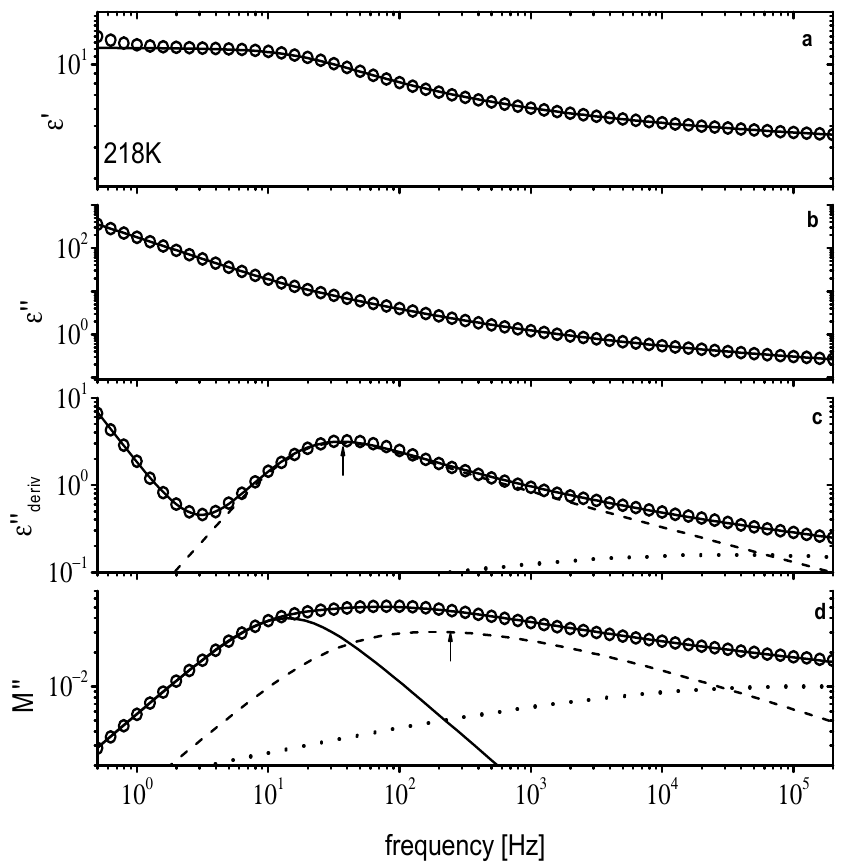
Figure 6. Dielectric data for [N 8881 ]Lev at 218 K. ε′(f) in ( a ), ε″(f) in ( b ), ε″ deriv (f) in ( c ), and M″(f) in ( d ). Solid lines are fitting curves. In ( c , d ) individual relaxations are shown as dashed and dotted lines. The solid line in ( d ) is conductivity relaxation (see text for details). The arrows in ( c , d ) indicate the main peak position.